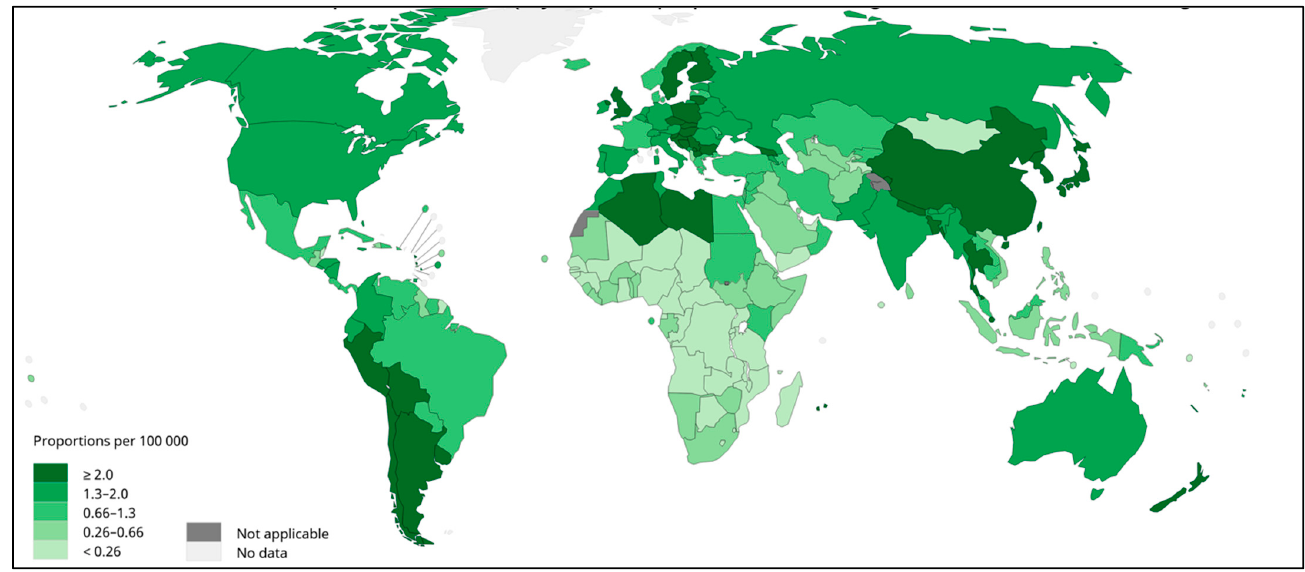
Figure 1. Gallbladder cancer incidence in both sexes, worldwide, 2020. Estimated age-standardized rates (World) per 100,000 per year. Data source: GLOBOCAN 2020. WHO, IARC: https://gco.iarc.fr/today/ (accessed on 23 July 2022)